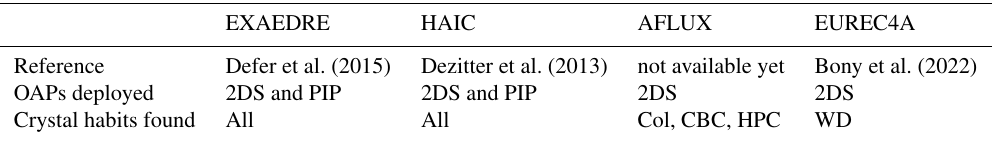
Table 2. All the PIP images in the original data set originate from two events in the EXAEDRE campaign and three events of the HAIC campaign. The context of these events are thunderstorms in the Mediterranean Sea for EXAEDRE and mesoscale convective systems in French Guiana for HAIC. Most of the 2DS data also originate from the same events. The AFFLUX campaign data were extracted from a single flight in stratiform clouds in the Arctic to provide more Col, CBCs, and HPCs of various sizes. Finally, all the water droplets of the 2DS data set were captured during a single flight in liquid water clouds in the Caribbean Sea during the EUREC4A